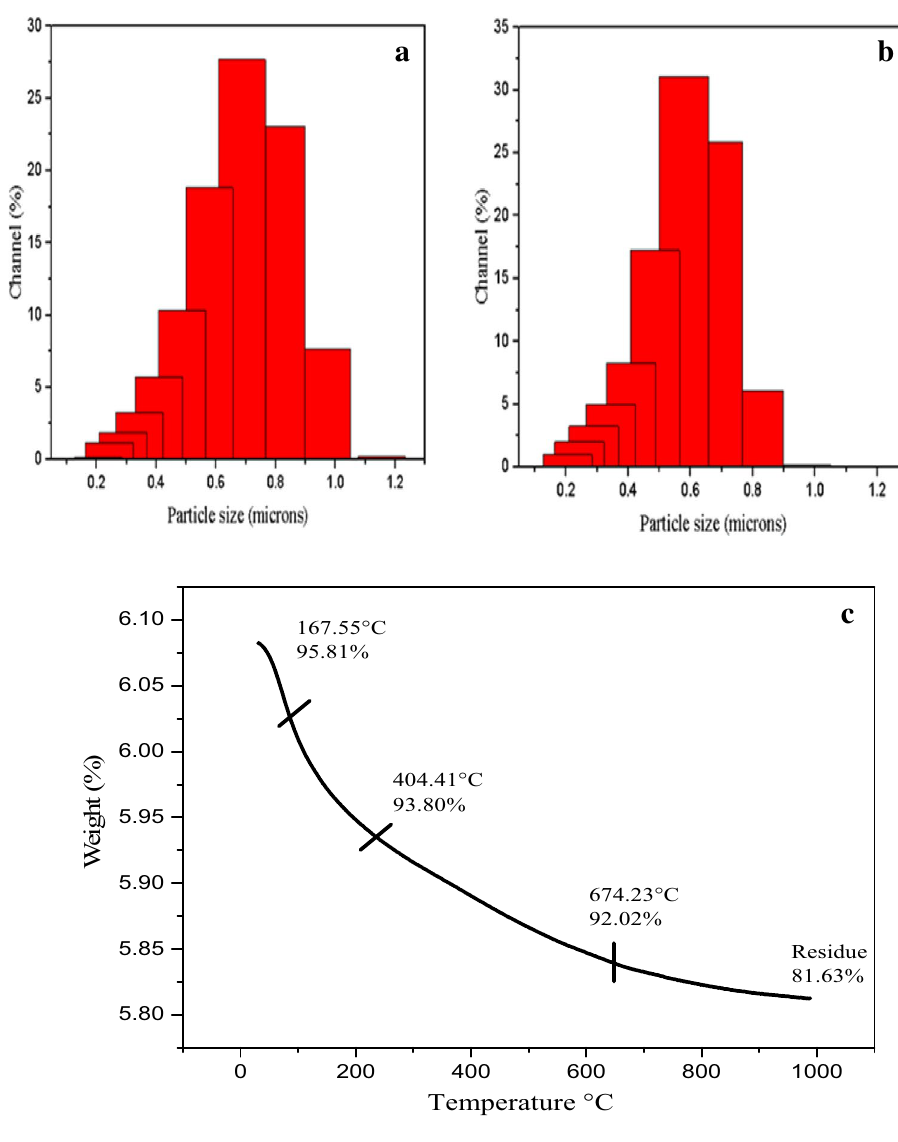
Fig. 8 particle size distribu- tion of a snail shell powder, b carbonated apatite powder and c TGA analysis of snail shell